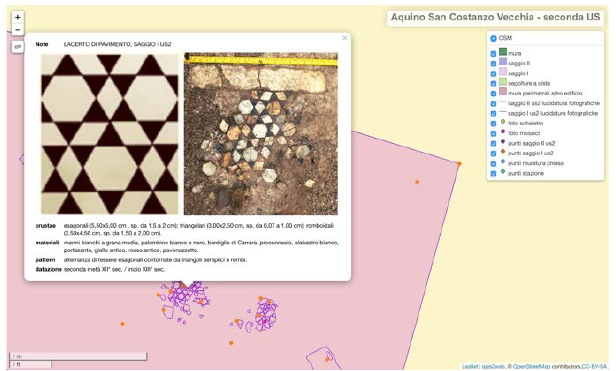
Figure 6. An example of a user friendly Q-GIS